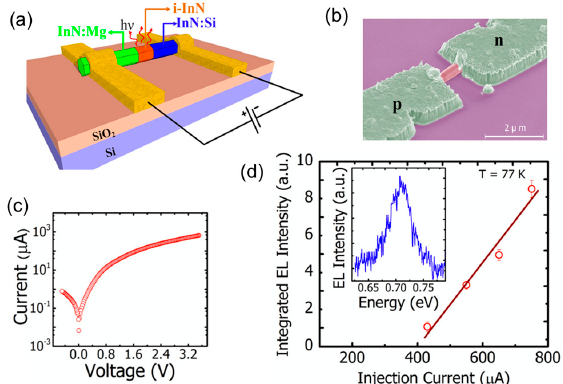
Figure 6. ( a ) Schematic of a single InN nanowire p-i-n LED. ( b ) SEM image of a fabricated device. ( c ) The I-V characteristics measured at 77 K. ( d ) Integrated light intensity vs. injection current measured at 77 K, with the inset showing a spectrum measured at an injection of 0.5 mA. The line is guide-for-eye [70].